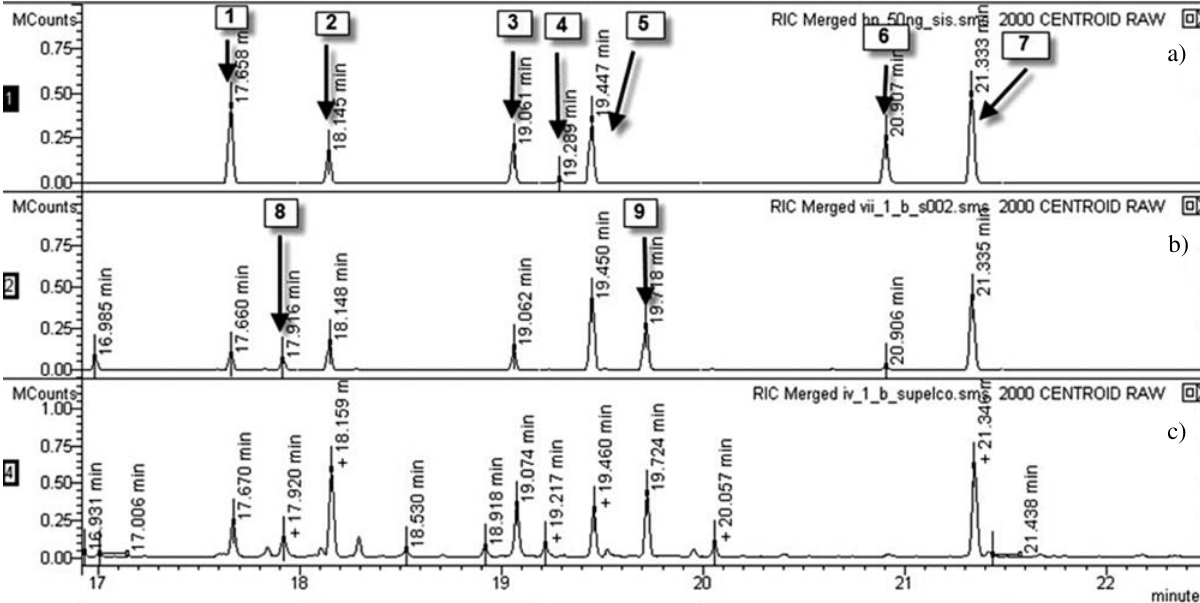
Figure 2. Typical chromatograms of selected PAs recorded in: a) SIM mode of standard mixture; b) SIM mode of red wine extract and c) SCAN mode of red wine extract (1. vanillic acid; 2. o -coumaric acid; 3. syringic acid; 4. cis- ferulic acid; 5. trans-p -coumaric acid; 6. trans- ferulic acid; 7. trans- caffeic acid; 8. cis-p -coumaric acid; 9. L-ascorbic acid